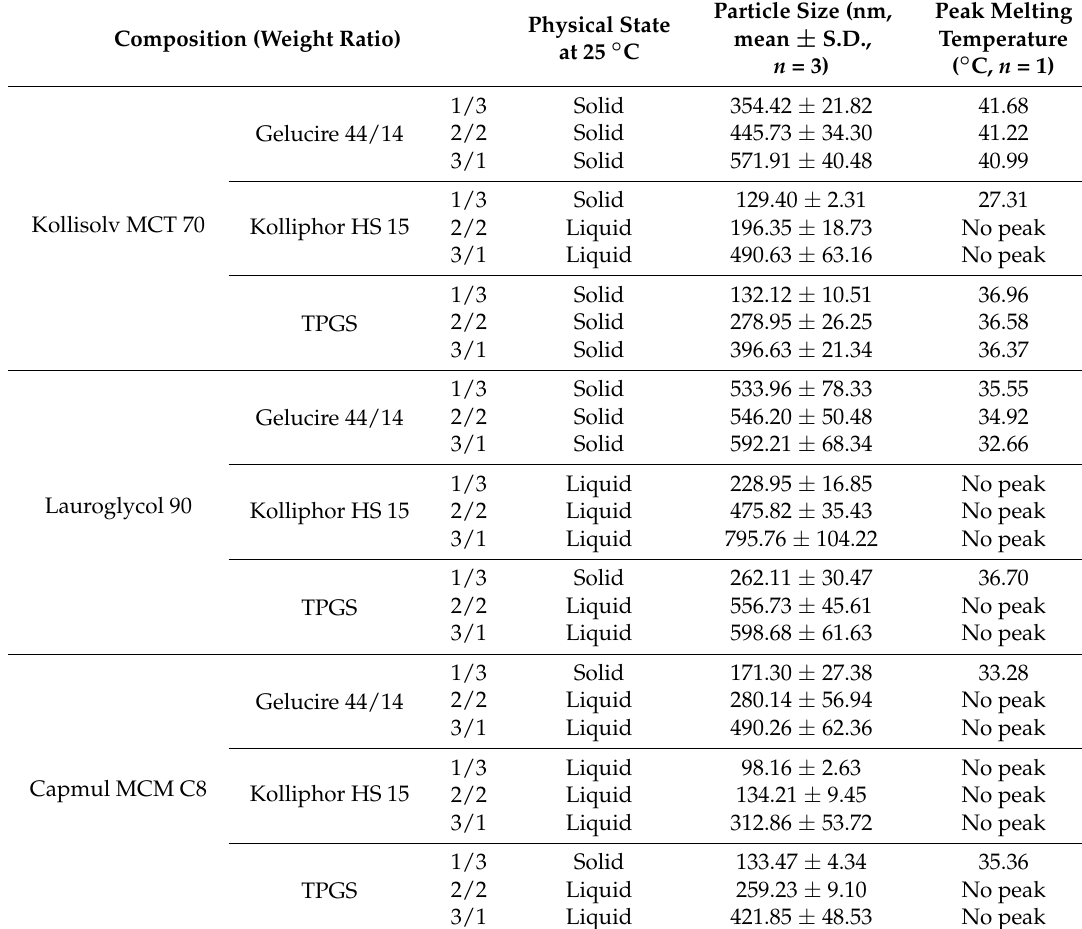
Table 1. Physical properties according to the vehicle compositions.